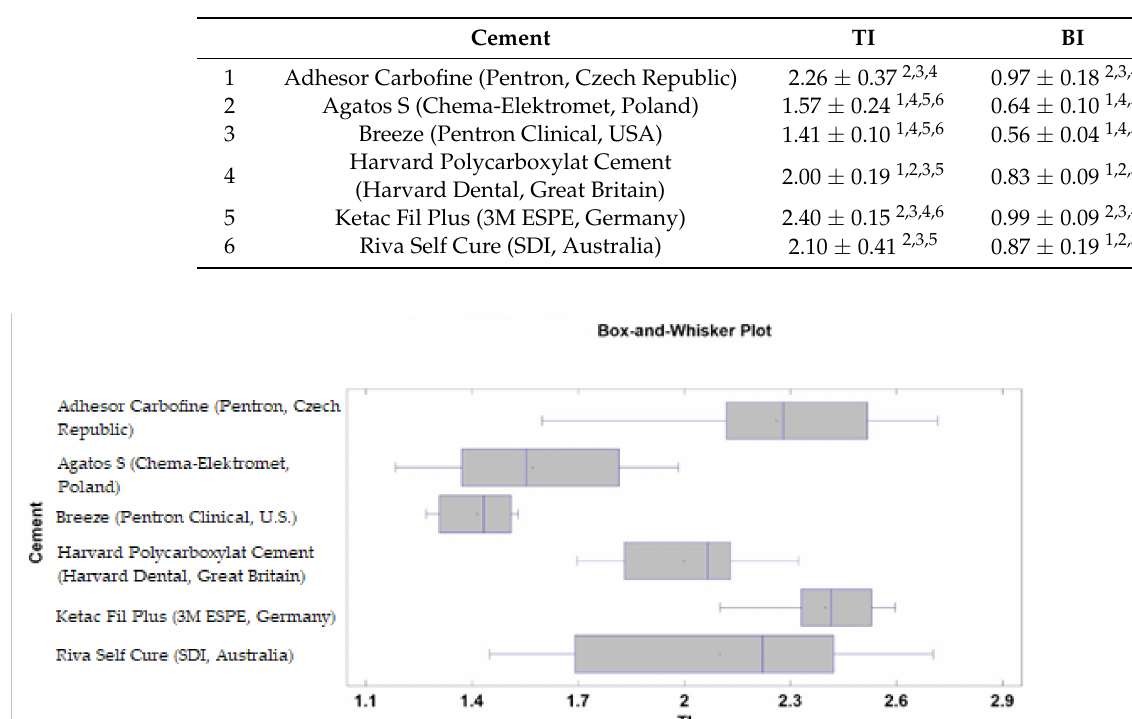
Figure 9. Texture index (TI) calculated for tested cements. The most expanded surface can be seen in Adhesor Carbofine (Pentron, Czech Republic) and Ketac Fil Plus (3M ESPE, Germany) contrary to Agatos S (Chema-Elektromet, Poland) and Breeze (Pentron Clinical, USA) presenting the lowest developed surface ( p <